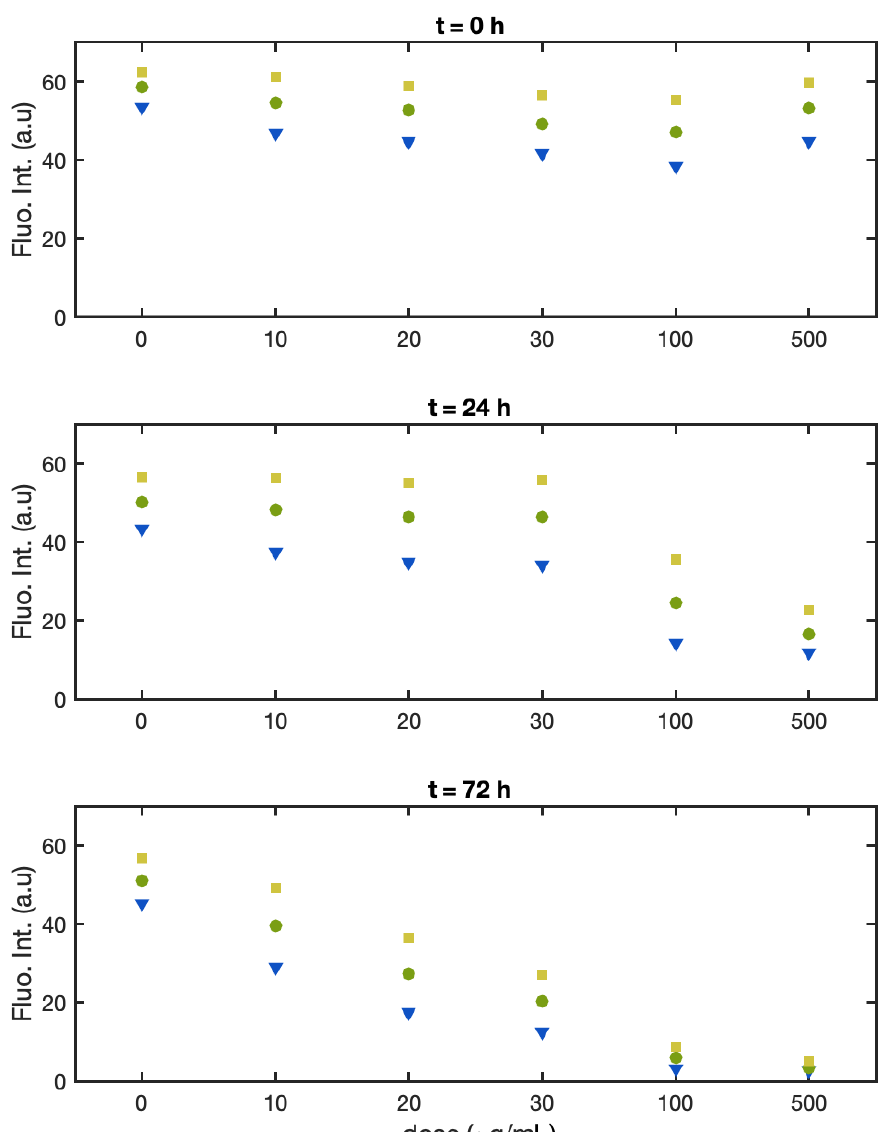
Figure 3. Batch 1: Normalized fluorescence intensity of the single alga cells at the 25th percentile (yellow square), median (green dot), and 75th percentile (blue triangle) as a function of Cu(II) concentration at t = 0 ( upper panel ), t = 24 h ( middle panel ), and t = 72 h ( lower panel ). Batch 2: